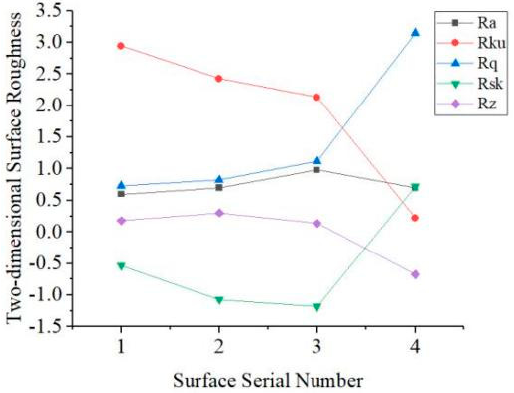
Figure 13. Two ‐ dimensional surface roughness of microgroove surfaces.